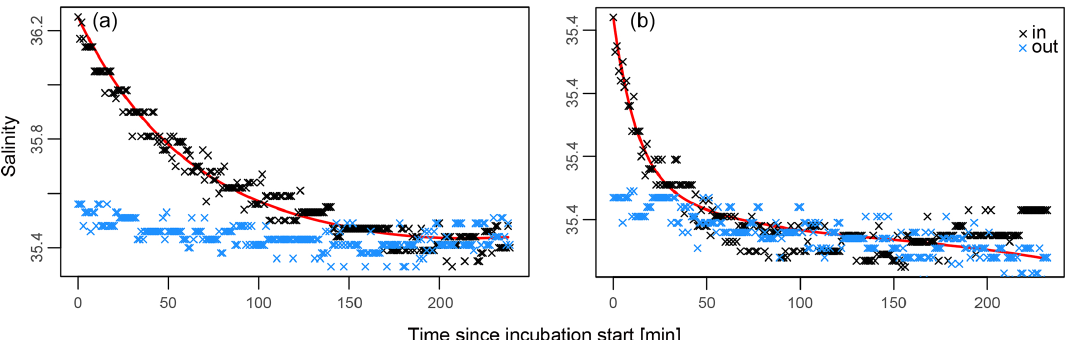
Figure 4. (a, b) Best fit explaining in-tent salinity at any given time (Eq. 1, red line). In-tent salinity measurements are in black, and ambient salinity measurements are in blue. Panel (a) illustrates an incubation that leaked relatively slowly with K = 0 . 0192 (0 . 0192 × 108 = 2 . 1Lmin), while (b) depicts a more rapidly leaking tent with K = 0 . 044 (0 . 044 × 108 = 4 . 8Lmin).